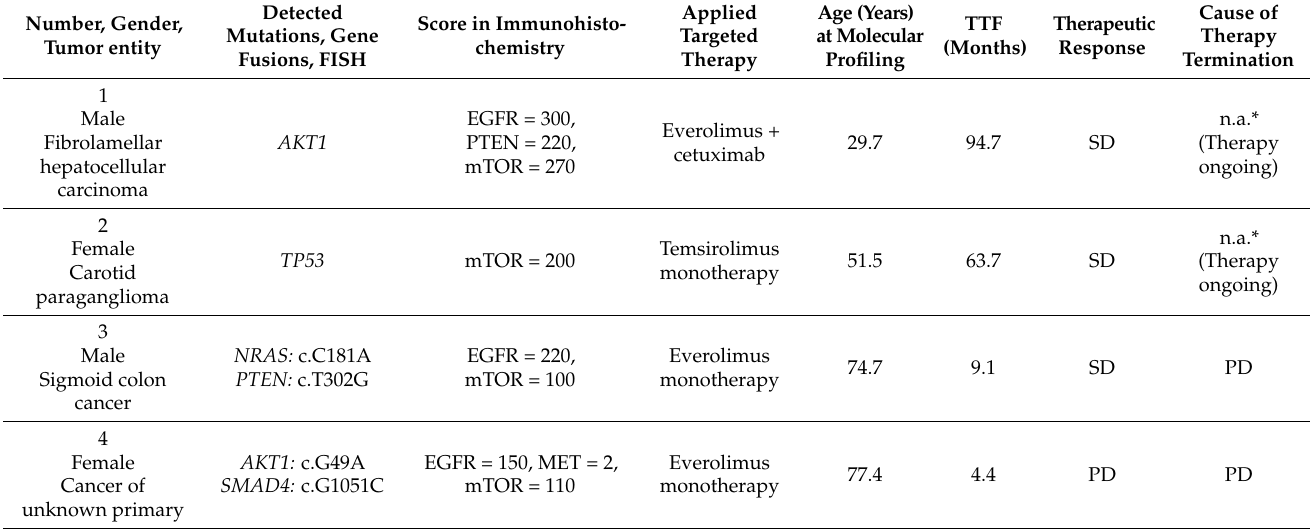
Table 4. Characteristics of the cancer patients receiving mTOR-inhibitor-based therapy ( n =